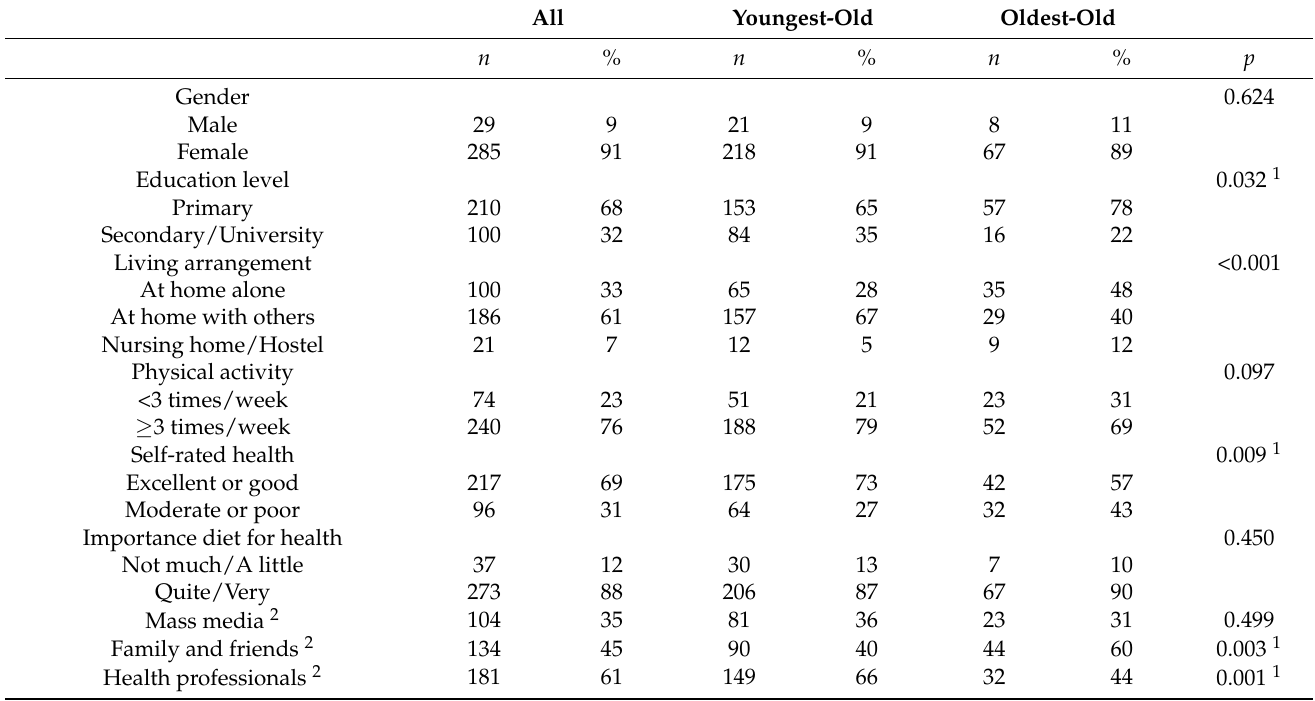
Table 1. Self-reported characteristics of study sample in the validation of the Myths-Nutrition Literacy Questionnaire, Myths-NL.